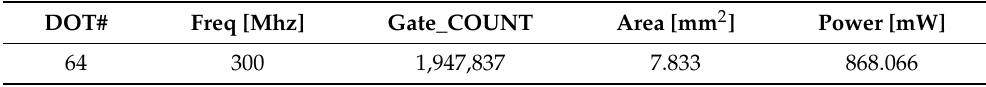
Table 7. SRMLC ASIC TSMC 40 nm implementation